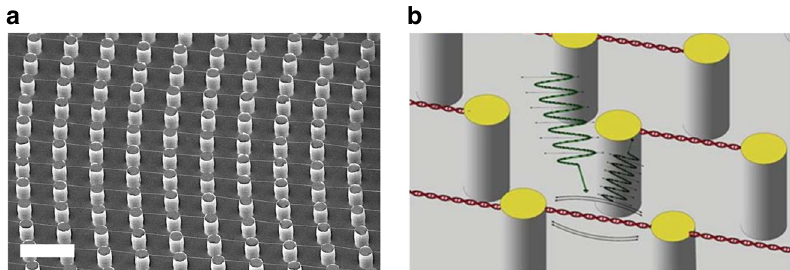
Fig. 4 Representative DNA bundle and the mechanical vibrating scheme. a SEM image showing suspended bundles between pillars. b The cartoon symbolizes the mechanical vibration of the DNA bundle with the incoming and re fl ected laser beams used to detect the frequency and amplitude of